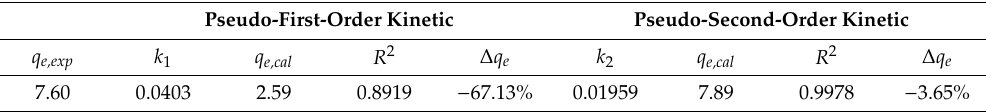
Table 1. Kinetic parameters for adsorption of tetracycline. Pseudo-First-Order